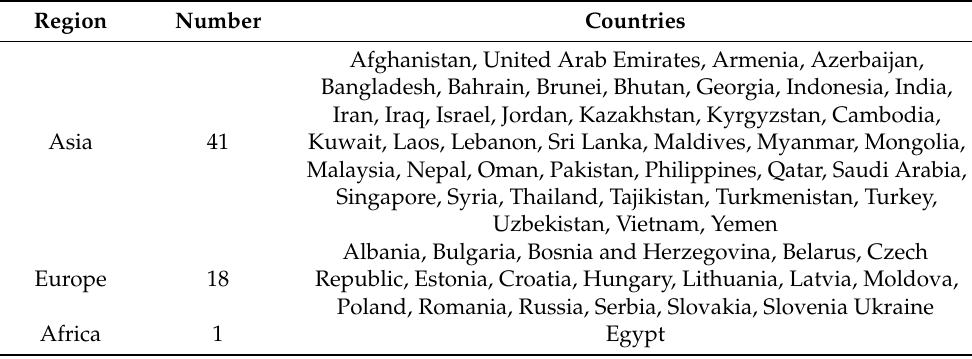
Table A2. The BRI countries studied in this